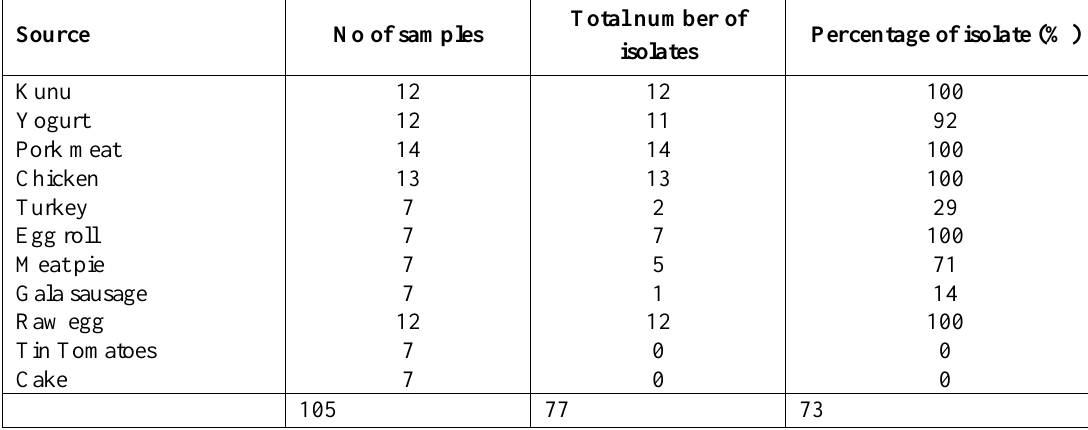
Table 1. Incidence of Salmonella species in some food and meat product samples.